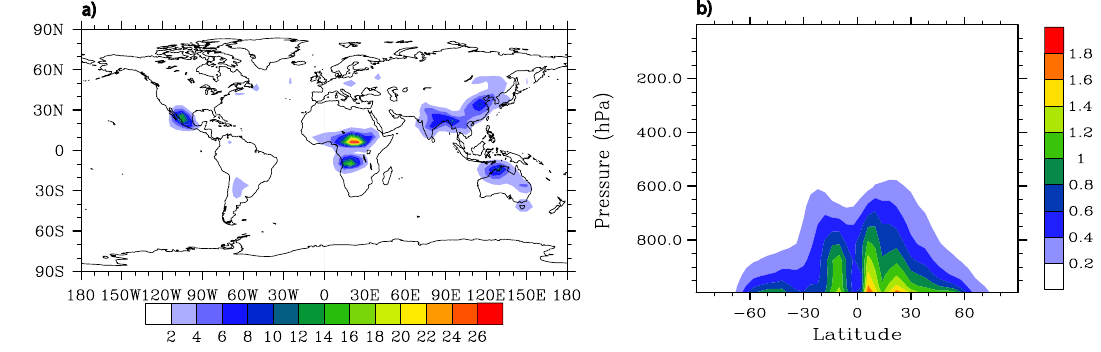
Fig. 1. Annual mean simulated surface POA concentrations (a) and zonal distrutubion of POA concentrations (b) . Units: µgm − 3 .